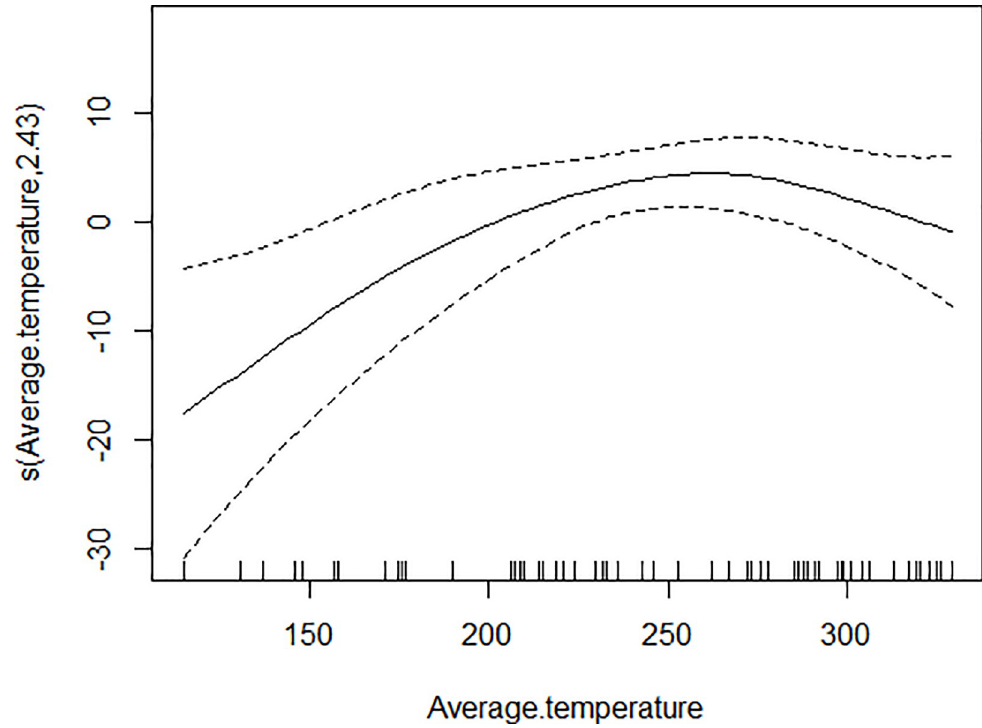
Fig 4. The relationship between CI and average temperature.